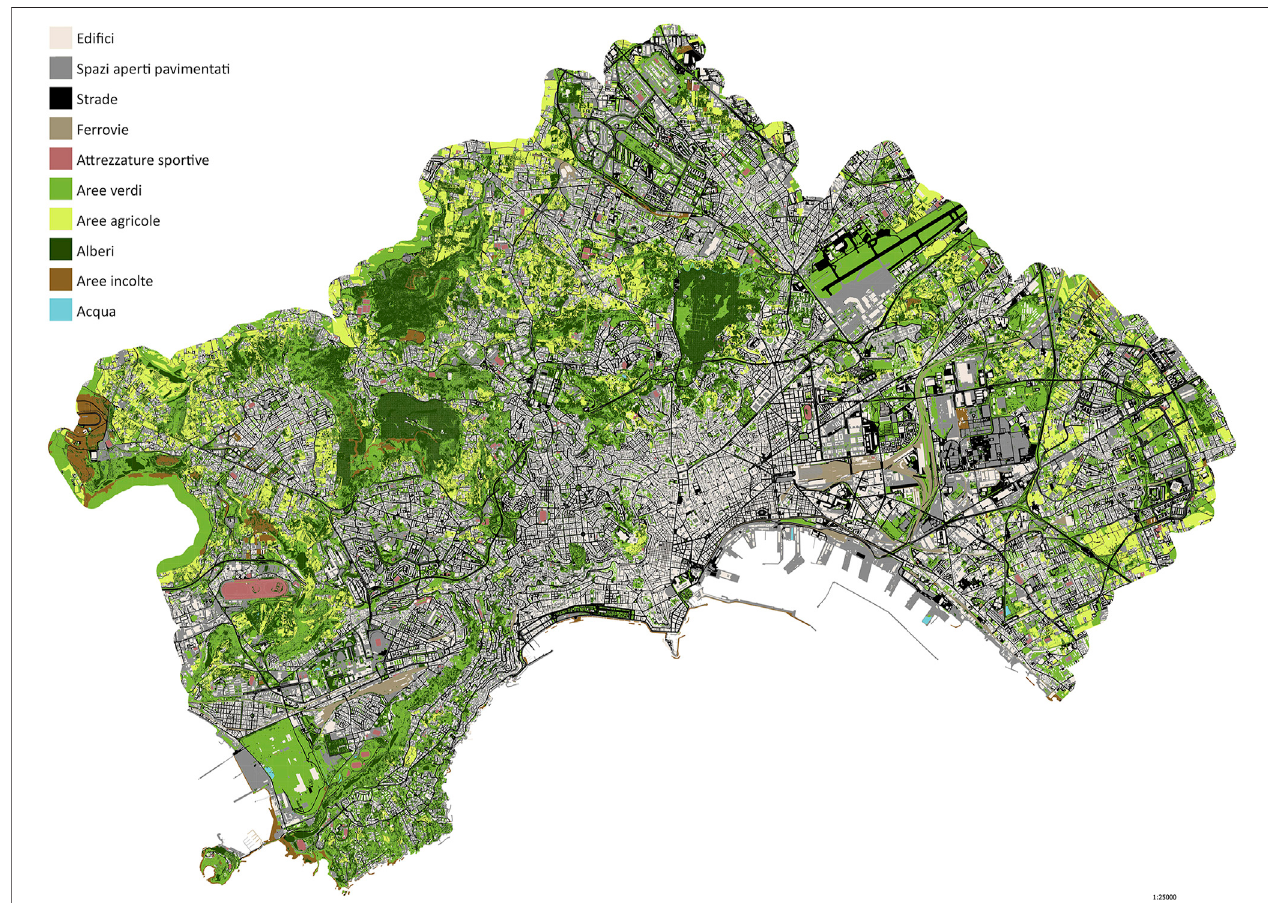
FIGURE 8 | Updated land use map of Naples used from HWLEM and FLEM